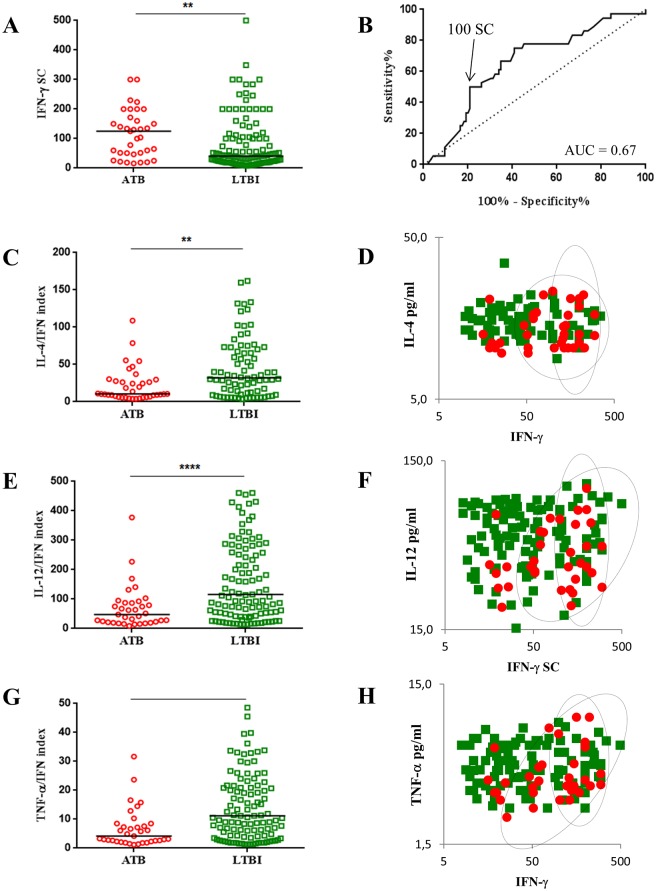
Cytokines response in T-SPOT supernatants.A- The expression of IFN-γ in ESAT-6 stimulated T cells was quantified by the T-SPOT assay. Results are expressed by numbers of secreted cells (SC) per 250 000 PBMC for 36 patients with ATB (red circles) and 115 patients with LTBI (green squares). The median is shown in each group. The p value is calculated by the Mann-Whitney U test. ** corresponds to p≤0.01. B- The ROC curve displays sensitivity vs specificity for IFN-γ in differentiating the ATB group from the LTBI group. The AUC and a threshold at 100 SC/250000 PBMC are indicated in the graph. C-E-G-I-K-M- IL-4, IL-12, TNF-α, GM-CSF, Eotaxin and IFN-α indexes (cytokine/IFN-γ *100), ATB are represented by red circles and LTBI by green squares. The median indexes are shown in each group of each panel. p values are calculated by the Mann-Whitney U test. ** corresponds to p≤0.01, *** to p≤0.001 and **** to p≤0.0001. D-F-H-J-L-N- Biparametric graphs between the numbers of IFN-γ immunospots in response to ESAT-6 stimulation and the level of cytokines (pg/ml) in the corresponding supernatants. ATB are represented by red circles and LTBI by green squares. Defined risk groups are circled.